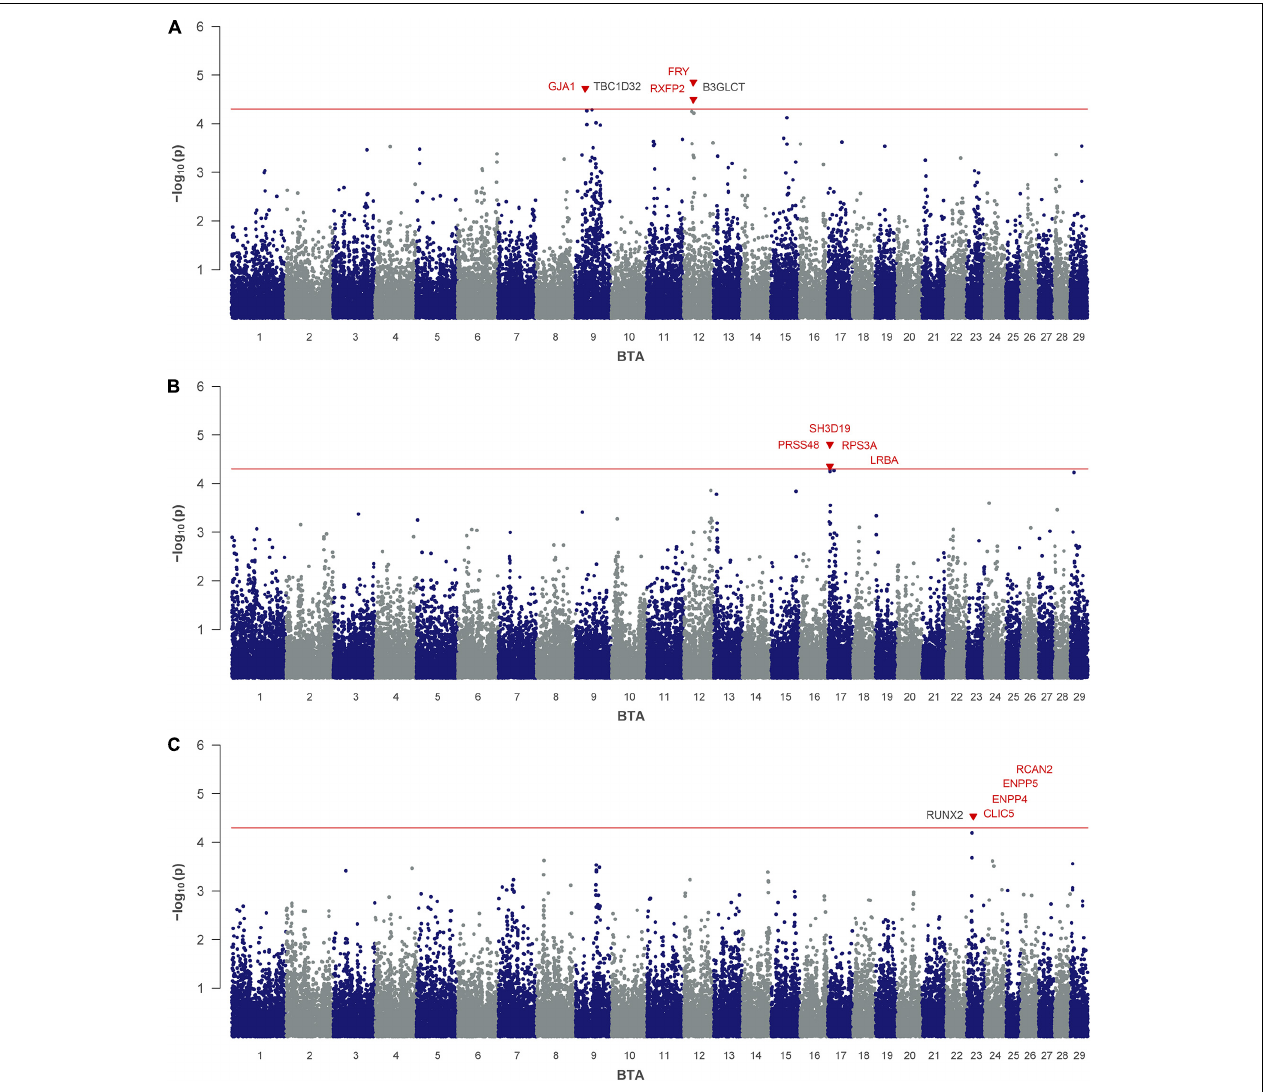
FIGURE 1 | Genome-wide association analysis of urea traits: (A) milk urea, (B) milk urea yield and (C) urinary urea. The red line indicates the threshold for suggestive significance. Genes with a suggested positional or biological association to the trait are indicated in red. Genes, located closest to the right and left of the lead SNP in a 1-Mb window are colored in